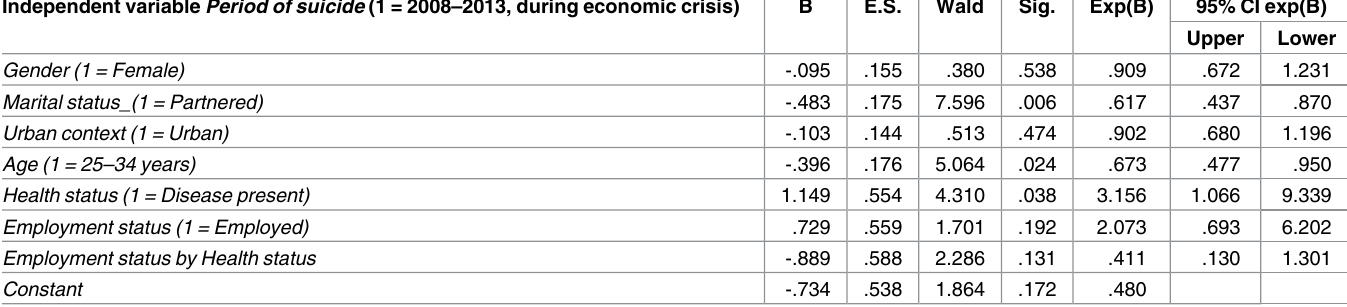
Table 4. Binary logistic